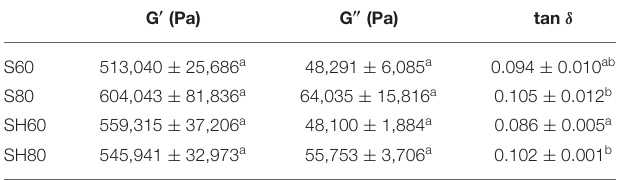
TABLE 4 | Viscoelastic rheological parameters (at 1Hz) of oleogels. G ′ (Pa) G ′′